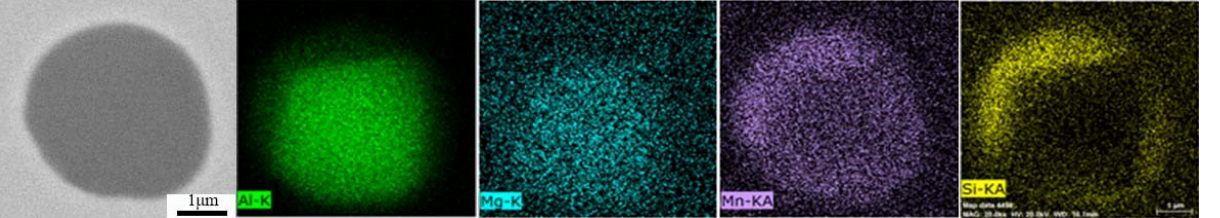
Figure 7: The elemental mapping of typical inclusion in steel when the time of 20min (MgO-Al 2 O 3 -SiO 2 -MnO)